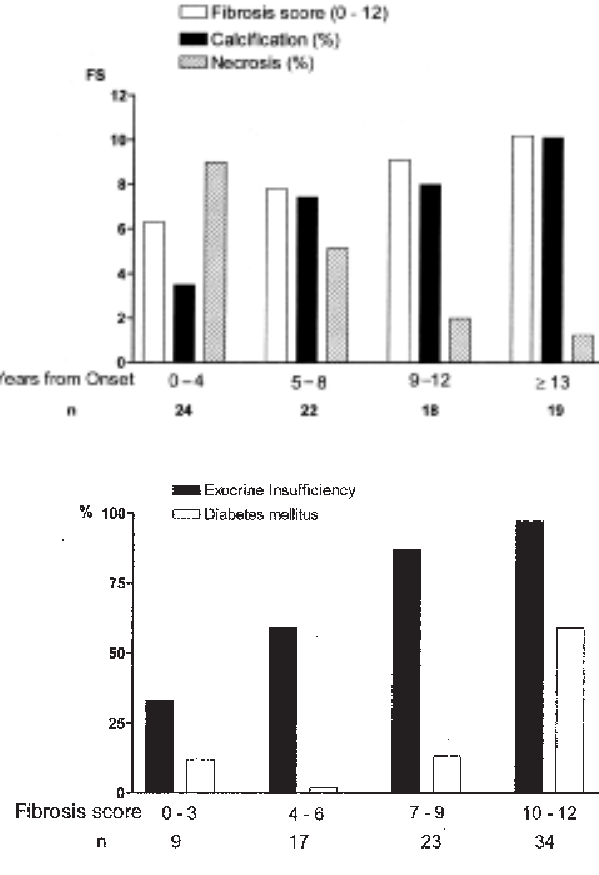
Evolution of histopathological changes in pan- creatic specimens of alcoholic chronic pancre- atitis (n = 73) in relation to years from onset ie fibrosis (FS, fibrosis score 0–12), calcification (%) and necrosis (%) (modified from ref. [2]). During the observation period (0 to >13 years from onset), an almost 2-fold increase of fibro- sis and a 3-fold increase of calcification was observed. Necrosis diminished from initially 75% to <10% during follow-up (in accordance with the necrosis-fibrosis-hypothesis; ref. [2]).